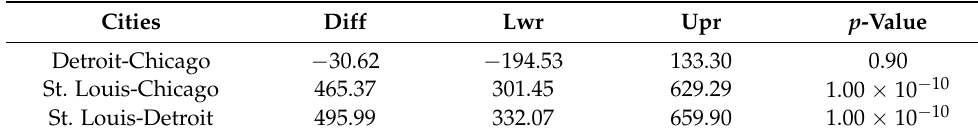
Table 3. Results of a Tukey HSD post hoc analysis reveal significant differences in the average cumulative growing degree days in 2016 between St. Louis and Chicago and between St. Louis and Detroit.